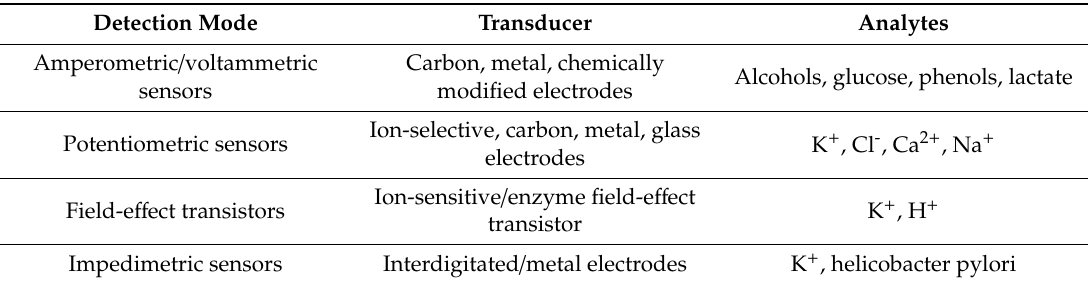
Table 1. Summary of the working principles of di ff erent electrochemical